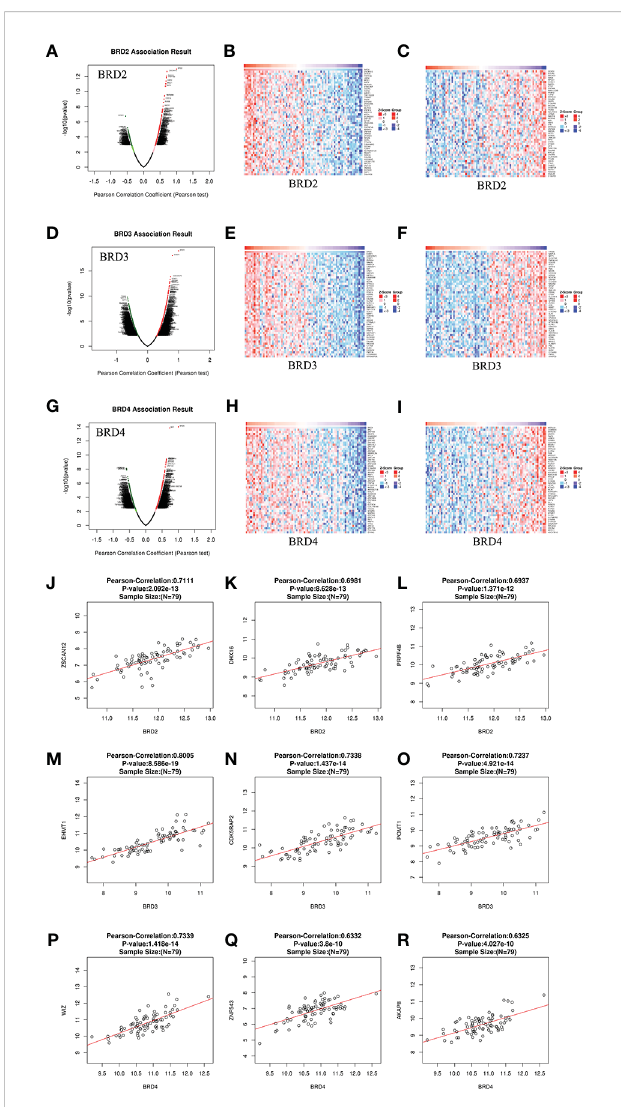
FIGURE 4 Genes differentially expressed in correlation with BET family expression in ACC (LinkedOmics). (A) Pearson test was used to analyze correlations between BRD2 expression and genes differentially expressed in patients with ACC; (B, C) Heatmaps showing genes positively and negatively correlated, respectively, with BRD2 in patients with ACC (top 50 genes); (D) Pearson test was used to analyze correlations between BRD3 expression and genes differentially expressed in patients with ACC; (E, F) Heatmaps showing genes positively and negatively correlated, respectively, with BRD3 in patients with ACC (top 50 genes); (G) Pearson test was used to analyze correlations between BRD4 expression and genes differentially expressed in patients with ACC; (H, I) Heatmaps showing genes positively and negatively correlated, respectively, with BRD4 in patients with ACC (top 50 genes). (J, K, L) The scatter plots show Pearson ’ s correlation of BRD2 expression with expression of ZSCAN12 , DHX16 , and PRPF4B , respectively, in patients with ACC; (M, N, O) The scatter plots show Pearson ’ s correlation of BRD3 expression with expression of EHMT1 , CDK5RAP2 , and POMT1 , respectively, in patients with ACC; (P, Q, R) The scatter plots show Pearson ’ s correlation of BRD4 expression with expression of WIZ , ZNF543 , and AKAP8 , respectively, in patients with